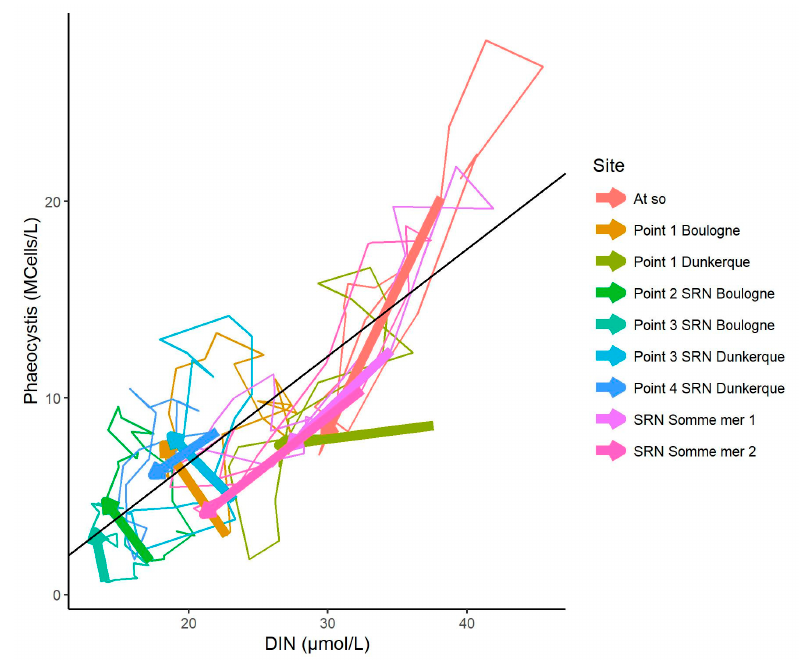
Figure 10. Temporal trajectories of the relationship between Phaeocystis and Dissolved Inorganic Nitrogen (DIN) concentrations by site and by period (six-year sliding periods between 1994 and 2018). The arrows indicate the overall trajectories (first period to last period). Complete trajectories are represented by thin colored lines.